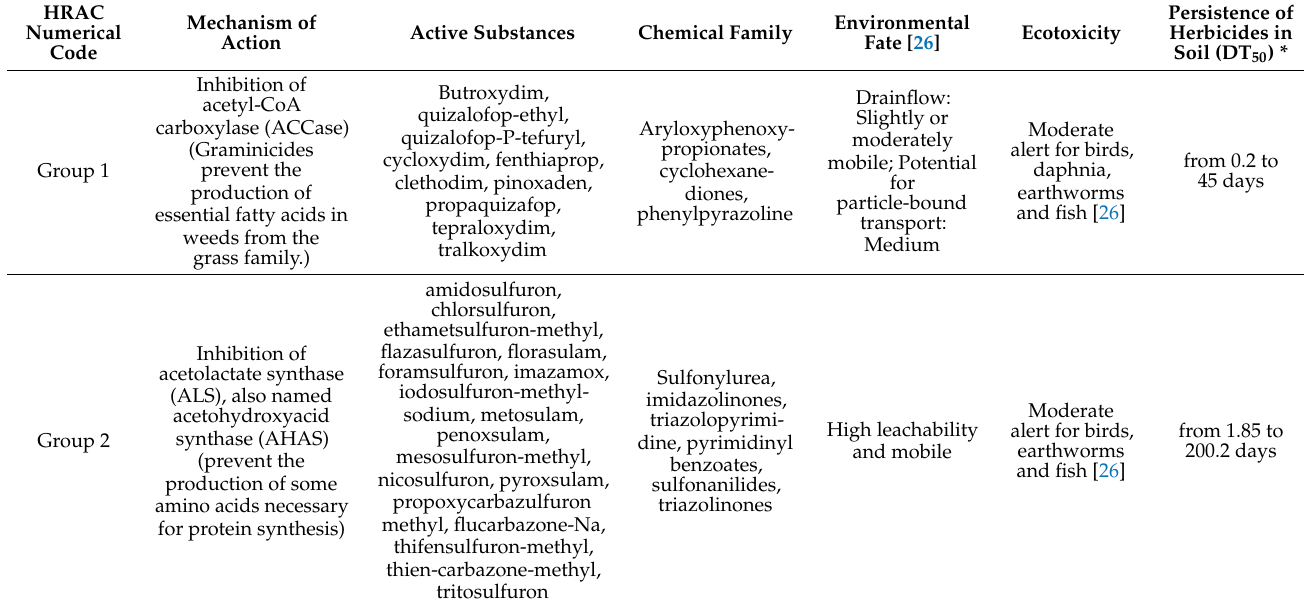
Table 1. Classification of selected herbicides based on active substances, chemical family, mechanism of action and environmental impact